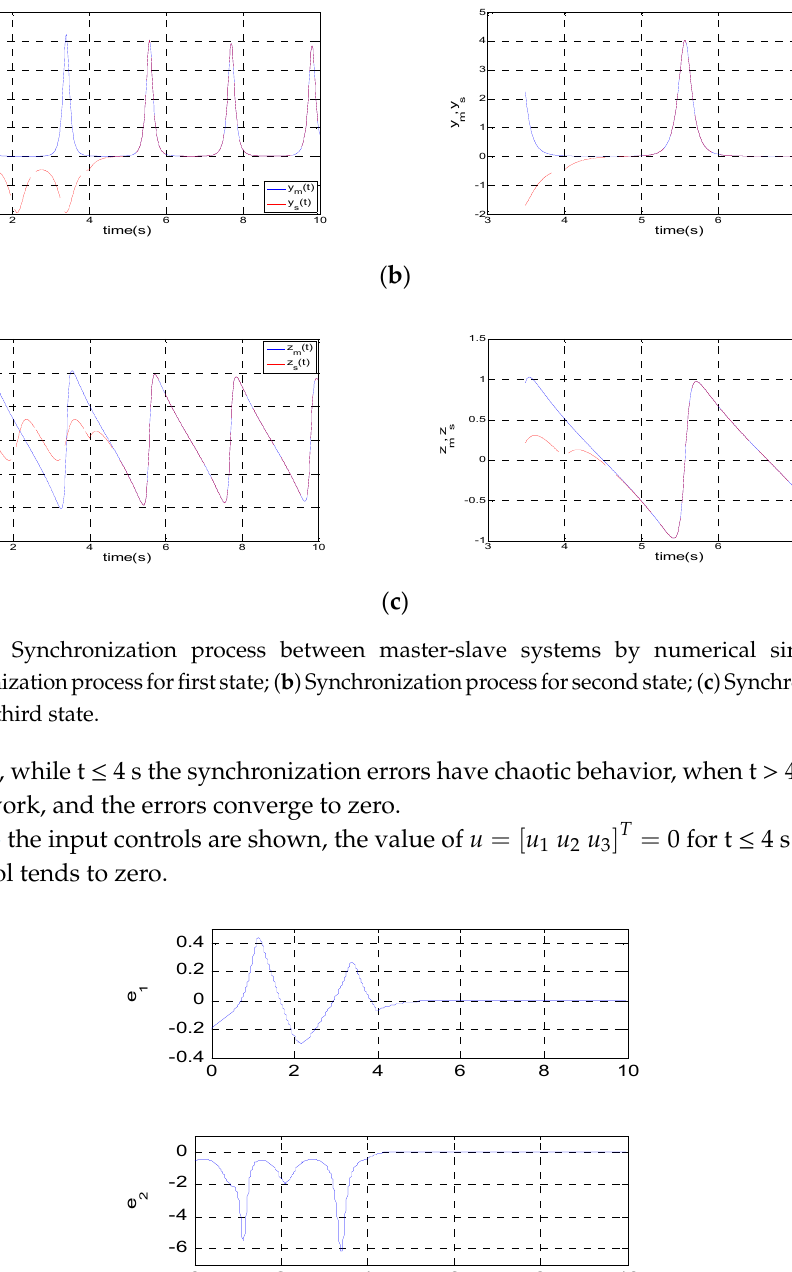
( b ) Figure 2. Chaotic attractor for master and slave systems; ( a ) 3D master attractor system; ( b ) 3D slave attractor system. Using the control laws of (10) and solving the system (11) of the synchronization error dynamics for 𝑘 (cid:2869) = 2, 𝑘 (cid:2870) = 5 and 𝑘 (cid:2871) = 5 , Figure 3 shows the synchronization process between the states of the master and slave systems. During the first seconds t ≤ 4 s, it is observed how the evolution of each state is different, after four seconds t > 4 s the control laws are activated, then the states of slave system begins to follow the states of the master system, achieving synchronization in approximately 2 s (t = 6 s).